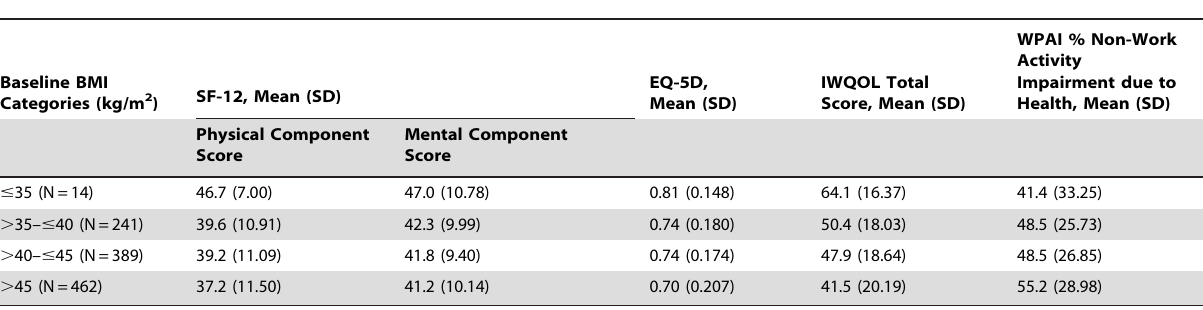
Table 5. Baseline Patient Reported Outcomes by